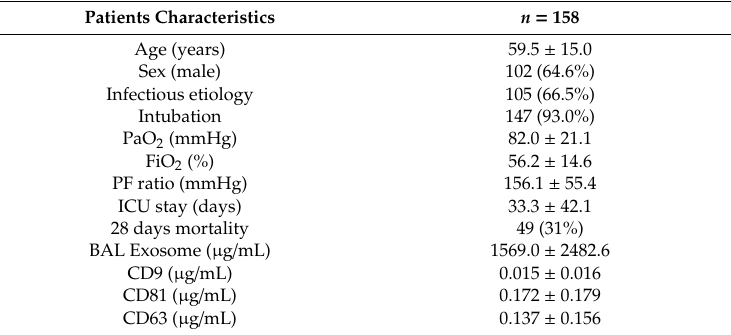
Table 1. Baseline characteristics of study